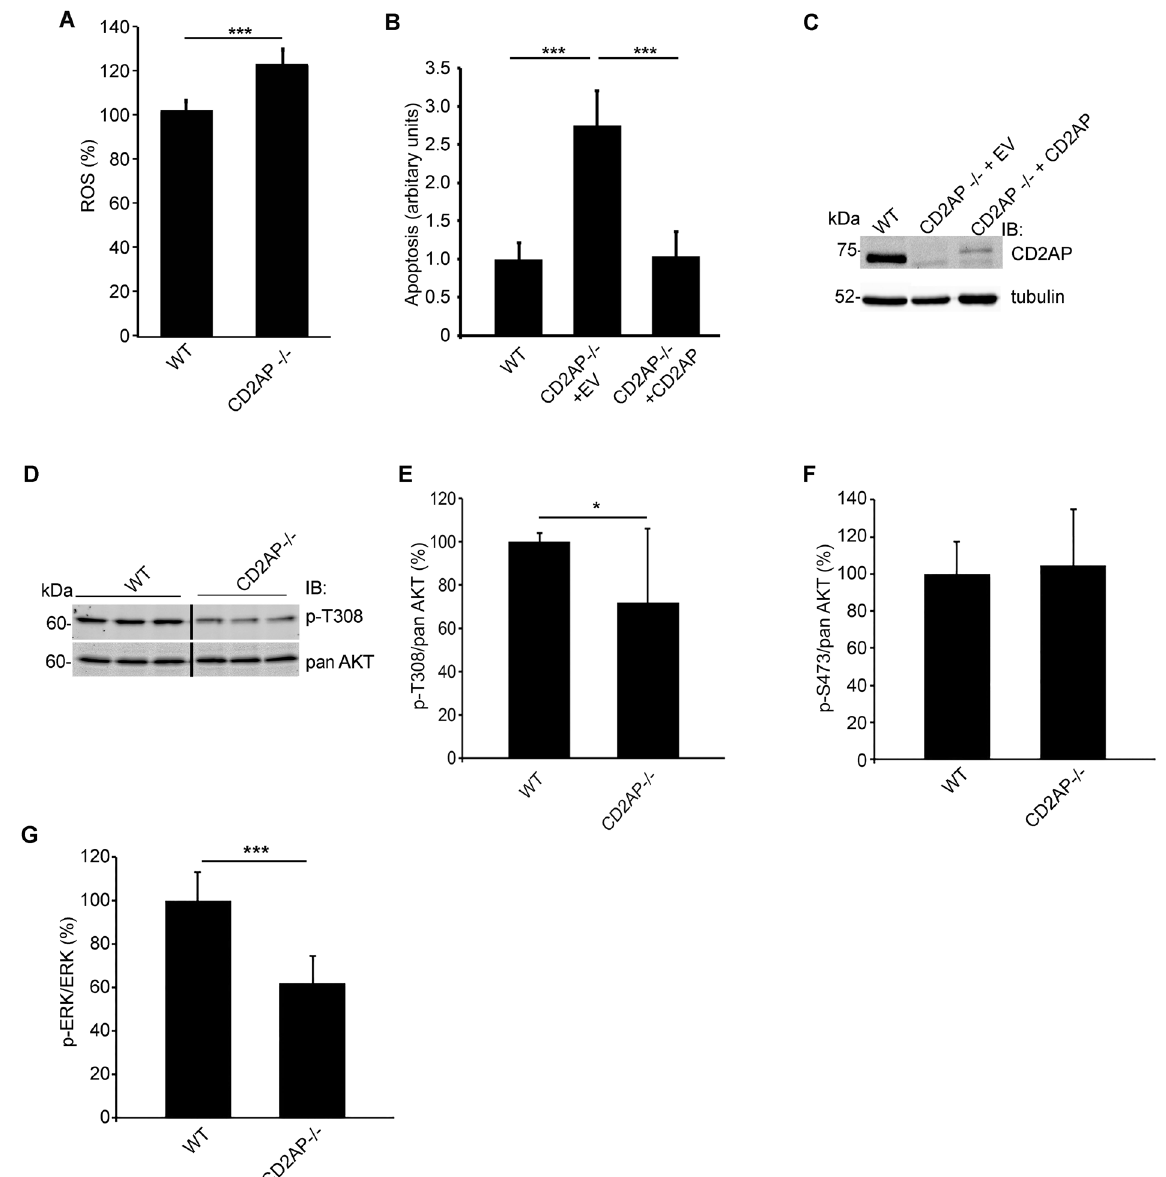
Figure 1. ROS generation and apoptosis are increased in CD2AP − / − podocytes. ( A ) ROS production is increased in the absence of CD2AP (CD2AP − / − ) compared to wild type (WT) podocytes as observed by DCFH-DA fluorescent probe assay. Hoechst 33342 was used for normalization. ( B ) Flow cytometry with annexin V and 7-AAD double labelling indicates that absence of CD2AP induces apoptosis. Reintroduction of CD2AP into CD2AP − / − podocytes rescues CD2AP − / − podocytes from apoptosis. ( C ) Representative immunoblot of CD2AP expression in WT podocytes, and in CD2AP − / − podocytes infected with lentiviruses containing an empty vector (EV) or human CD2AP cDNA. ( D,E ) Immunoblotting and quantification reveals that phosphorylation of AKT on T308 (p-T308) is reduced in CD2AP − / − podocytes compared to WT podocytes. Total AKT (panAKT) is used for normalization. Full width blot of (D) is shown in Supplemental Fig. S1A. (F) In-cell Western and quantification shows no difference in the phosphorylation of AKT on S473 (p- S473) in relation to total AKT (panAKT) between WT and CD2AP − / − podocytes. Both p-S473 and panAKT were normalized to nuclear marker DRAQ5 TM . (G) In-cell Western and quantification reveals that the ratio of phosphorylated ERK (p-ERK) to total ERK is significantly lower in CD2AP − / − podocytes compared to WT podocytes. Both p-ERK and total ERK were normalized to nuclear marker DRAQ5 TM . The experiments were performed three times with three replicates in each experiment. The bars show the mean expression in arbitrary units (error bars STDEV). * p < 0.05, *** p < 0.001, Student’s